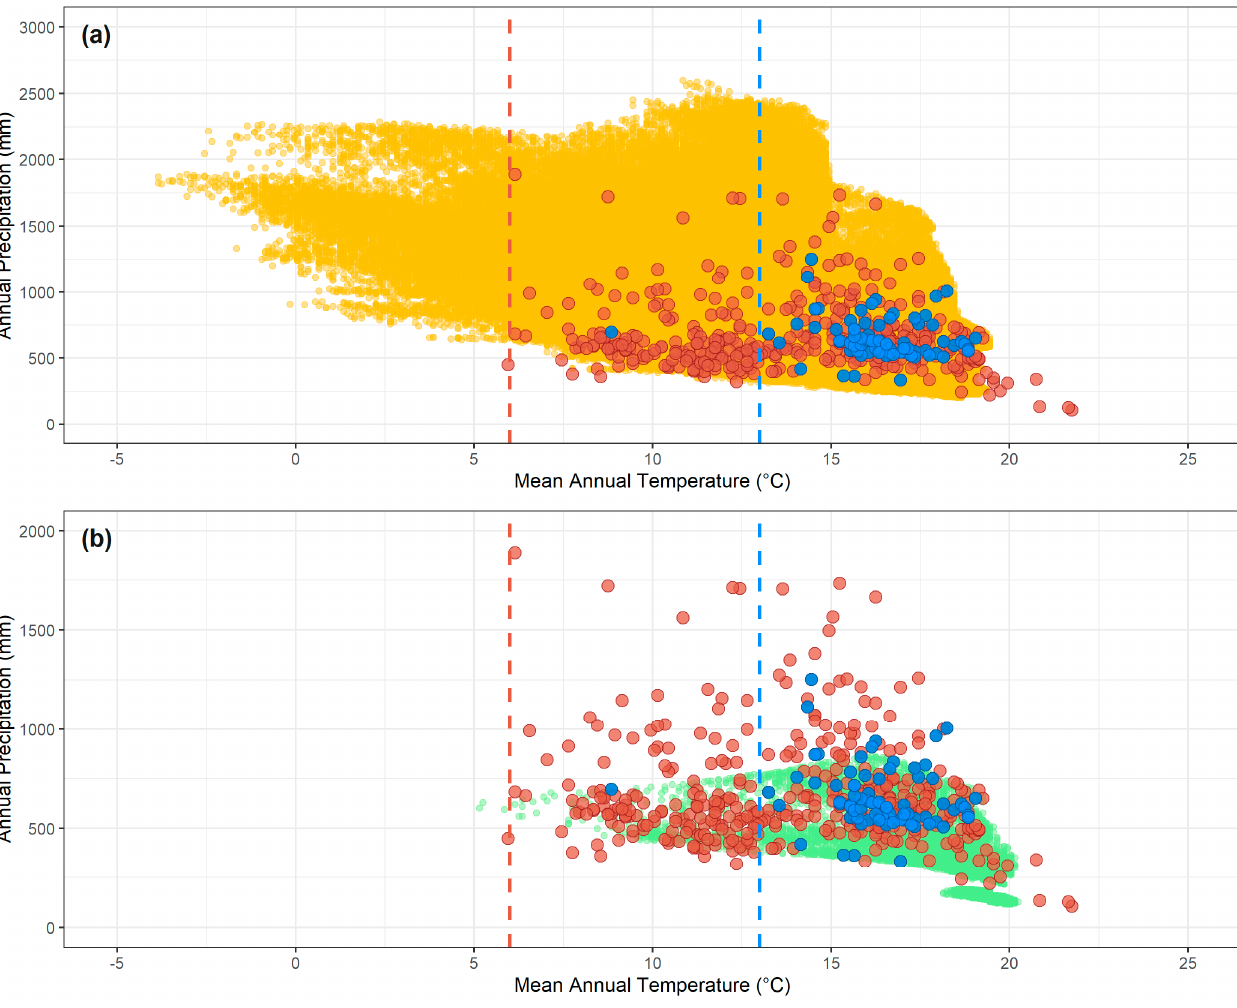
Figure 2. Representation of the environmental spaces available in ( a ) continental Spain (yellow dots), and in ( b ) the Canary Islands (light green dots) as defined by mean annual temperature and annual precipitation. The blue dots represent the environmental space occupied by the Hyalomma marginatum tick as restricted to the boundaries of continental Spain (77 non-duplicated occurrence records), whereas the red dots represent the environmental space occupied by its global occurrences (475 non-duplicated occurrence records). ( a ) A niche model of the H. marginatum tick, based solely on the occurrences in continental Spain (blue dots), will truncate the lower limit of the species’ thermal tolerance. Most of these boundary-restricted occurrences (blue dots) have been recorded in areas with mean annual temperatures superior to 13 ◦ C (blue dashed line), while the species withstands mean annual temperatures as lower as 6 ◦ C (red dots, red dashed line). Thus, a projected distribution based on this truncated niche model will underestimate those environments available in Spain with mean annual temperatures between 6 ◦ C and 13 ◦ C (between red and blue dashed lines). ( b ) A similar situation will occur if this same truncated niche model should be transferred to the Canary Islands to identify areas suitable for the establishment of H. marginatum populations. Such a model will fail to predict those areas in Canary Islands presenting mean annual temperatures between 6 ◦ C and 13 ◦ C (between red and blue dashed